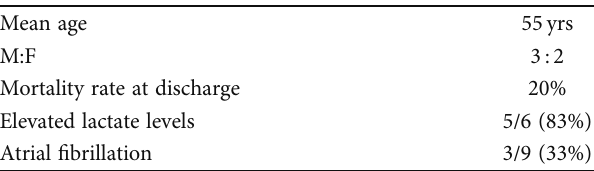
Table 1: Data averages of